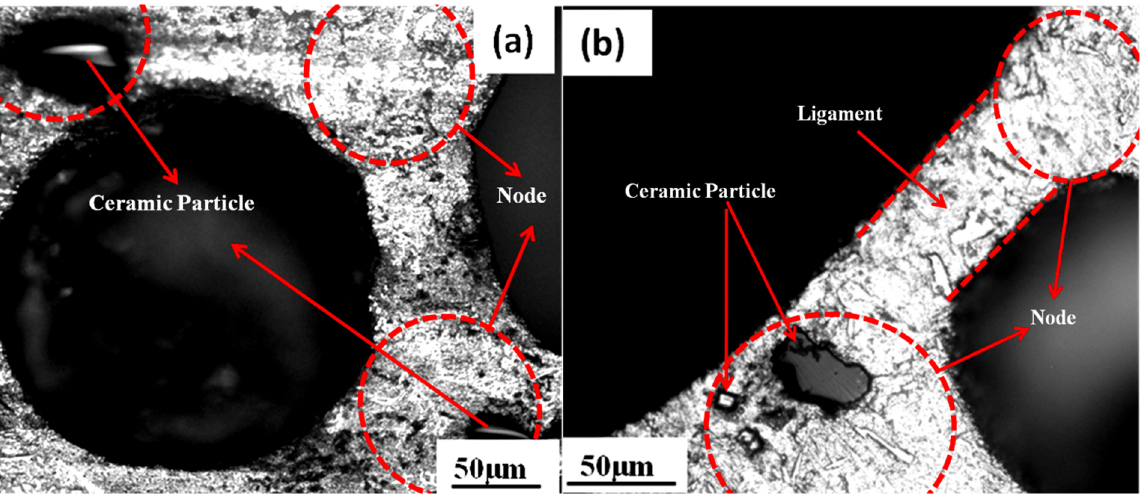
Figure 9. The images of ceramic reinforced particles on the ligament of composites foam cell at ( a ) 875 °C and ( b ) 900